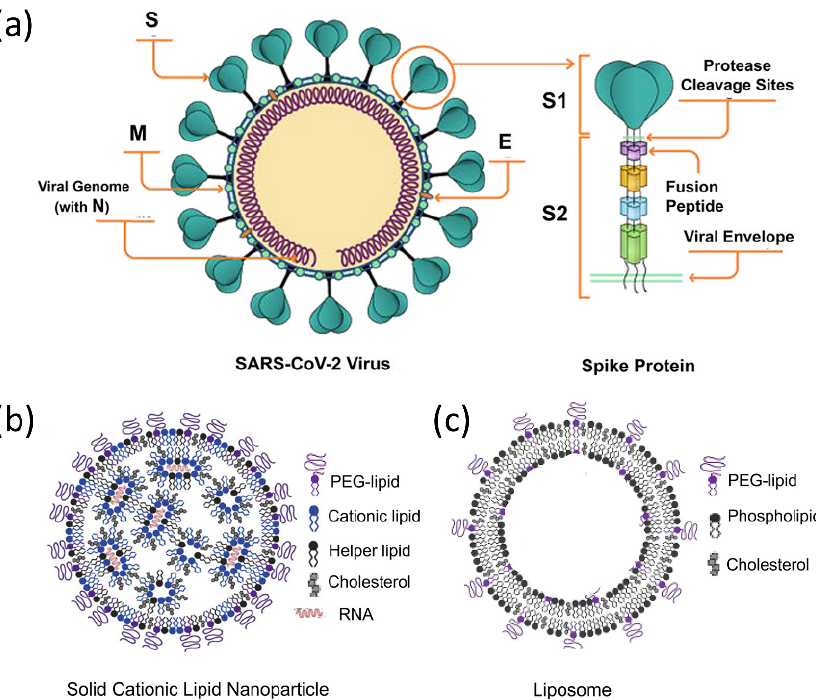
Figure 13. Responsive nanostructured materials for COVID-19 treatment and prevention. ( a ) Schematic illustration of the SARS-CoV-2 components for generating protective antiviral immune responses. ( b ) The proposed structure of LNP–siRNA formulations containing ionizable amino-lipids within inverted micellar structures surrounding siRNA. ( c ) Liposomal formulations contain an aqueous core with electron densities consistent with the exterior of the liposome. Reprinted from [55], with permission from American Chemical Society.